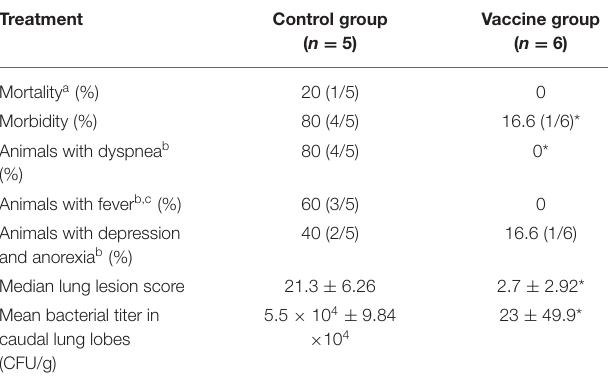
TABLE 2 | The results of challenge with Actinobacillus pleuropneumoniae serovar 1 in vaccinated and unvaccinated control pigs.